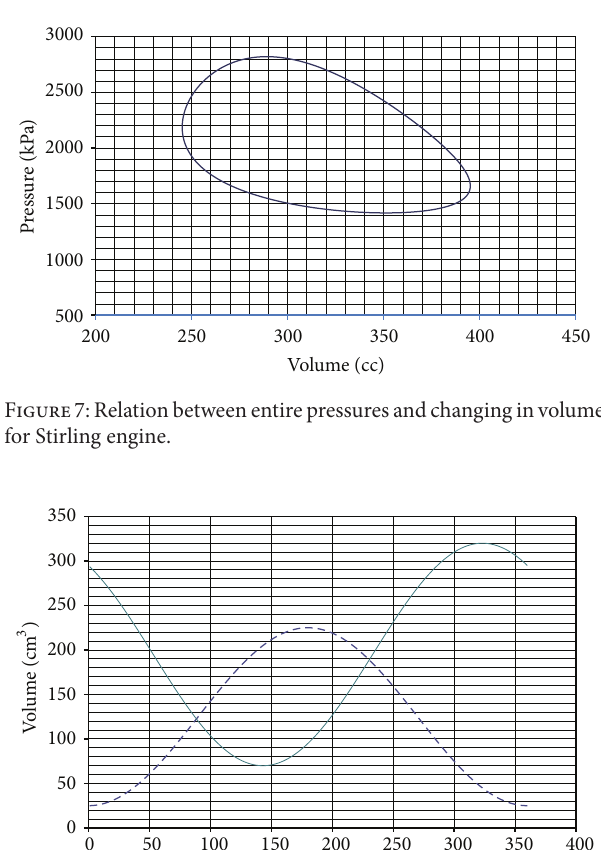
Figure 10: Changing of the pressure versus the crank angle for Stirling